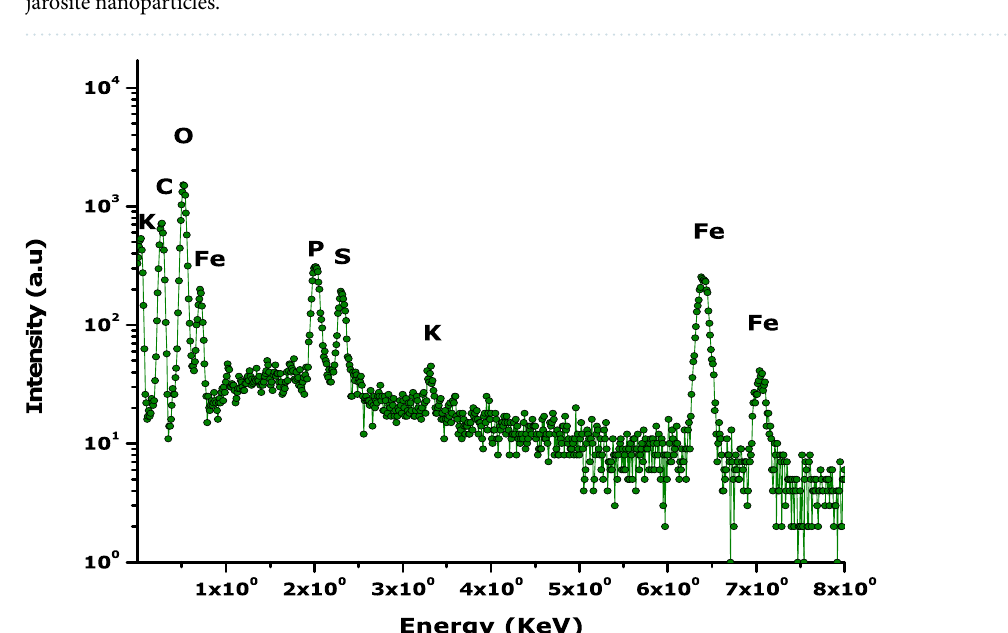
Figure 5. ( a ) UV–VIS spectroscopy, ( b ) Tauc plot, and ( c ) photoluminescence of the prepared hydronium jarosite nanoparticles.